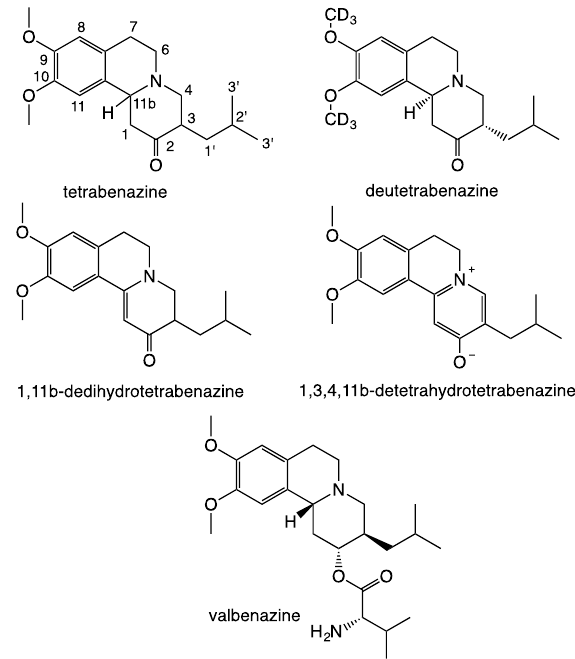
Figure 1. Structures of tetrabenazine (TBZ), deuterated TBZ, two tetrabenazine photolytic impurities and valbenazine.